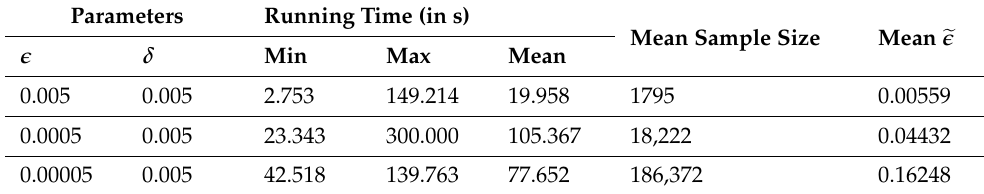
Table 3. Dyck 2: PAC DFA extraction from RNN.